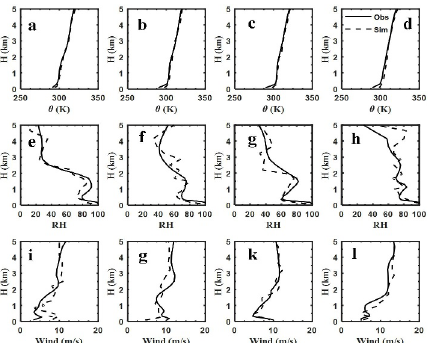
Fig.5 Comparison of WRF/Chem-simulated vertical profiles with radiosonde observed potential temperature, relative humidity (RH%), wind speed at 08:00 EDT, OKX Upton during the event (panels a), e) and i) for Aug. 27; b), f), and j) for Aug. 28; and c), g) and k) for Aug.29; d), h), l) for Aug.